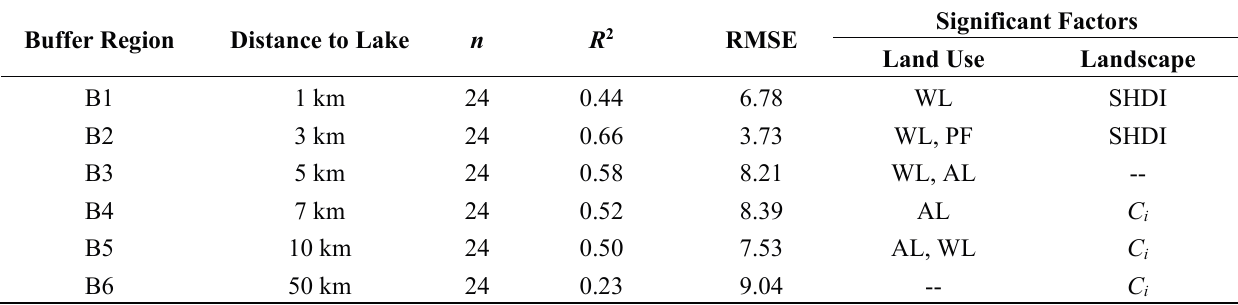
Table 3. Modeling result of LUCC indices and algae area as three divisions combined. Buffer